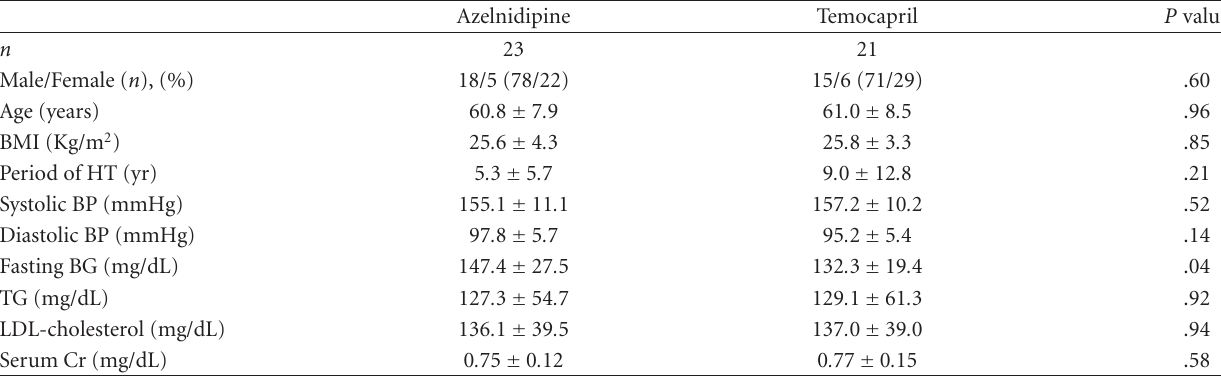
Table 2: Baseline characteristics of subjects treated with azelnidipine and temocapril.